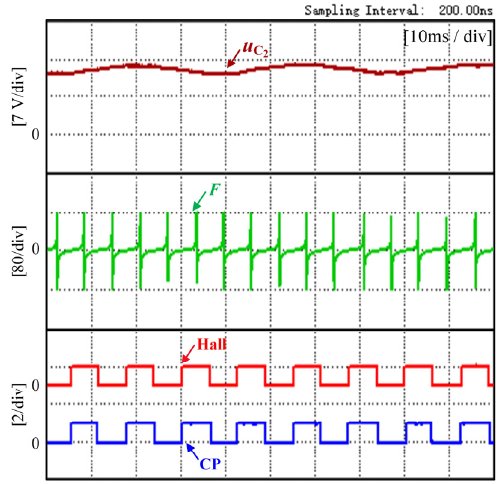
Figure 15. Experimental waveform under the condition of 400 r/min speed and 0.5 N·m torque.